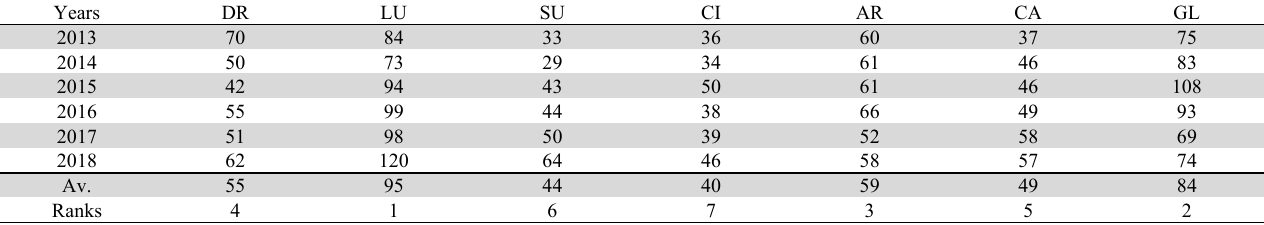
Average Cash conversion cycle (CCC) days and Ranks of selected leading Indian pharmaceutical companies (2013-18)